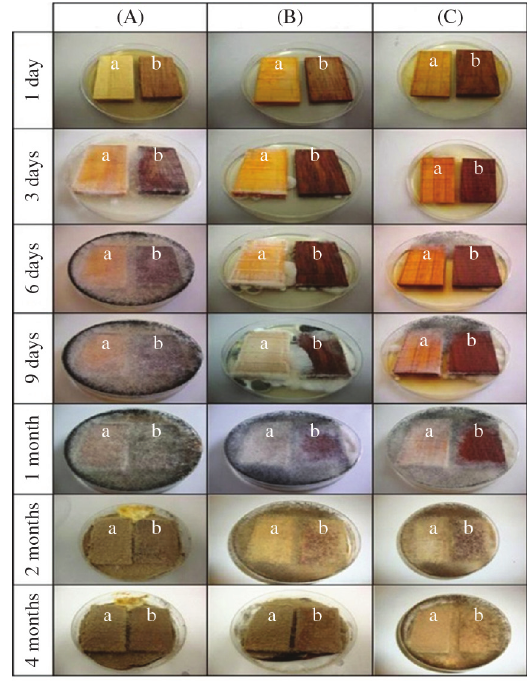
Figure 2. Omages of the samples in nutrient agar without (A) and with the presence of oleoresin capsaicin extracted from Capsicum baccatum (B) and Capsicum frutensens (C); a) Pinus sp . , b) Hymenae sp